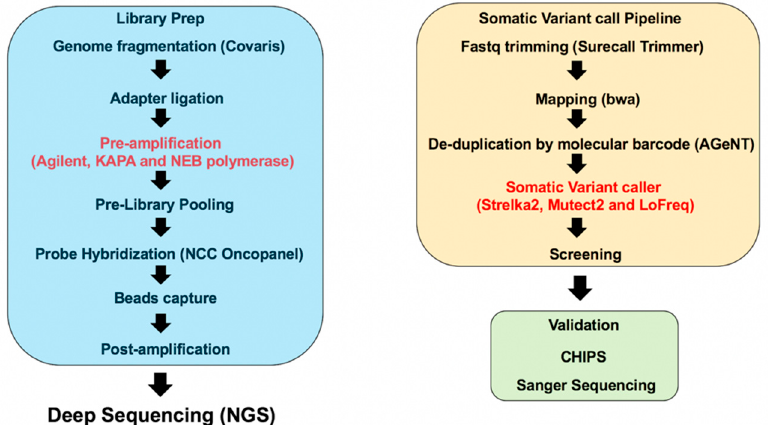
Figure 1. Workflow for somatic variant calling with next generation sequencing (NGS). During the library prep, we used three di ff erent DNA polymerases for pre-amplification to compare the fidelity of these polymerases. The sequencing data are the result of the somatic variant calling pipeline. We used three di ff erent somatic variant callers to compare the detected number of variants and accuracy of variant detection. Detected variants were validated using CHIPS and Sanger sequencing.